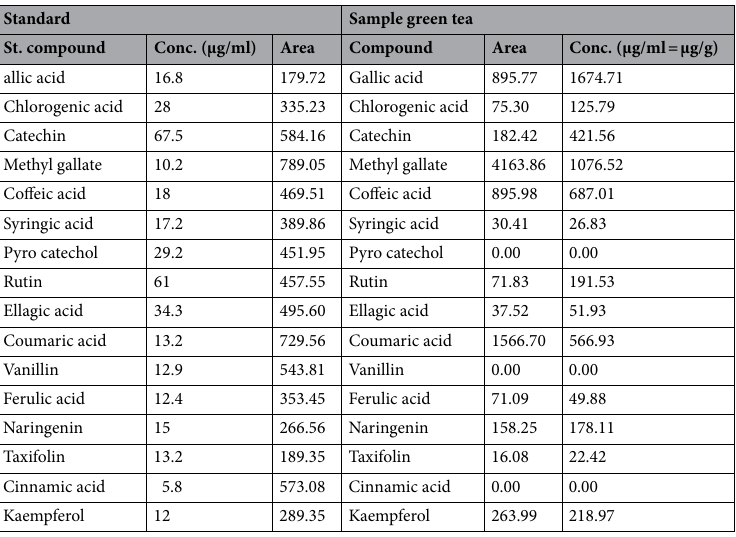
Table 13. HPLC analysis for Camellia sinensis.